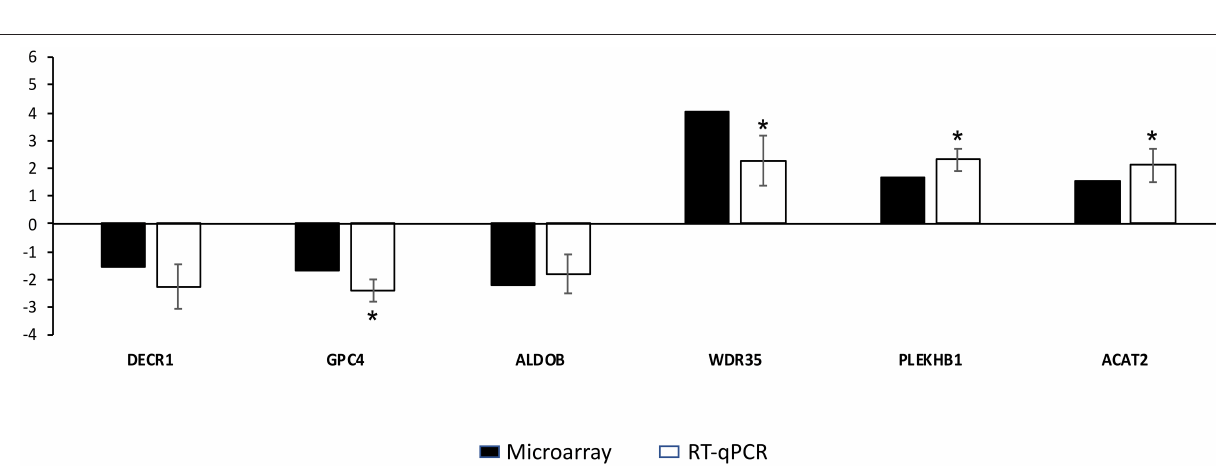
FIGURE 5 | Results of the quantitative real-time PCR (RT-qPCR) used to validate microarray results. The y-axis indicates the fold change of each differentially expressed gene in vitrified morulae compared to control morulae. Asterisks represent significant differences between groups as determined by RT-qPCR analysis. Bars represent mean standard errors